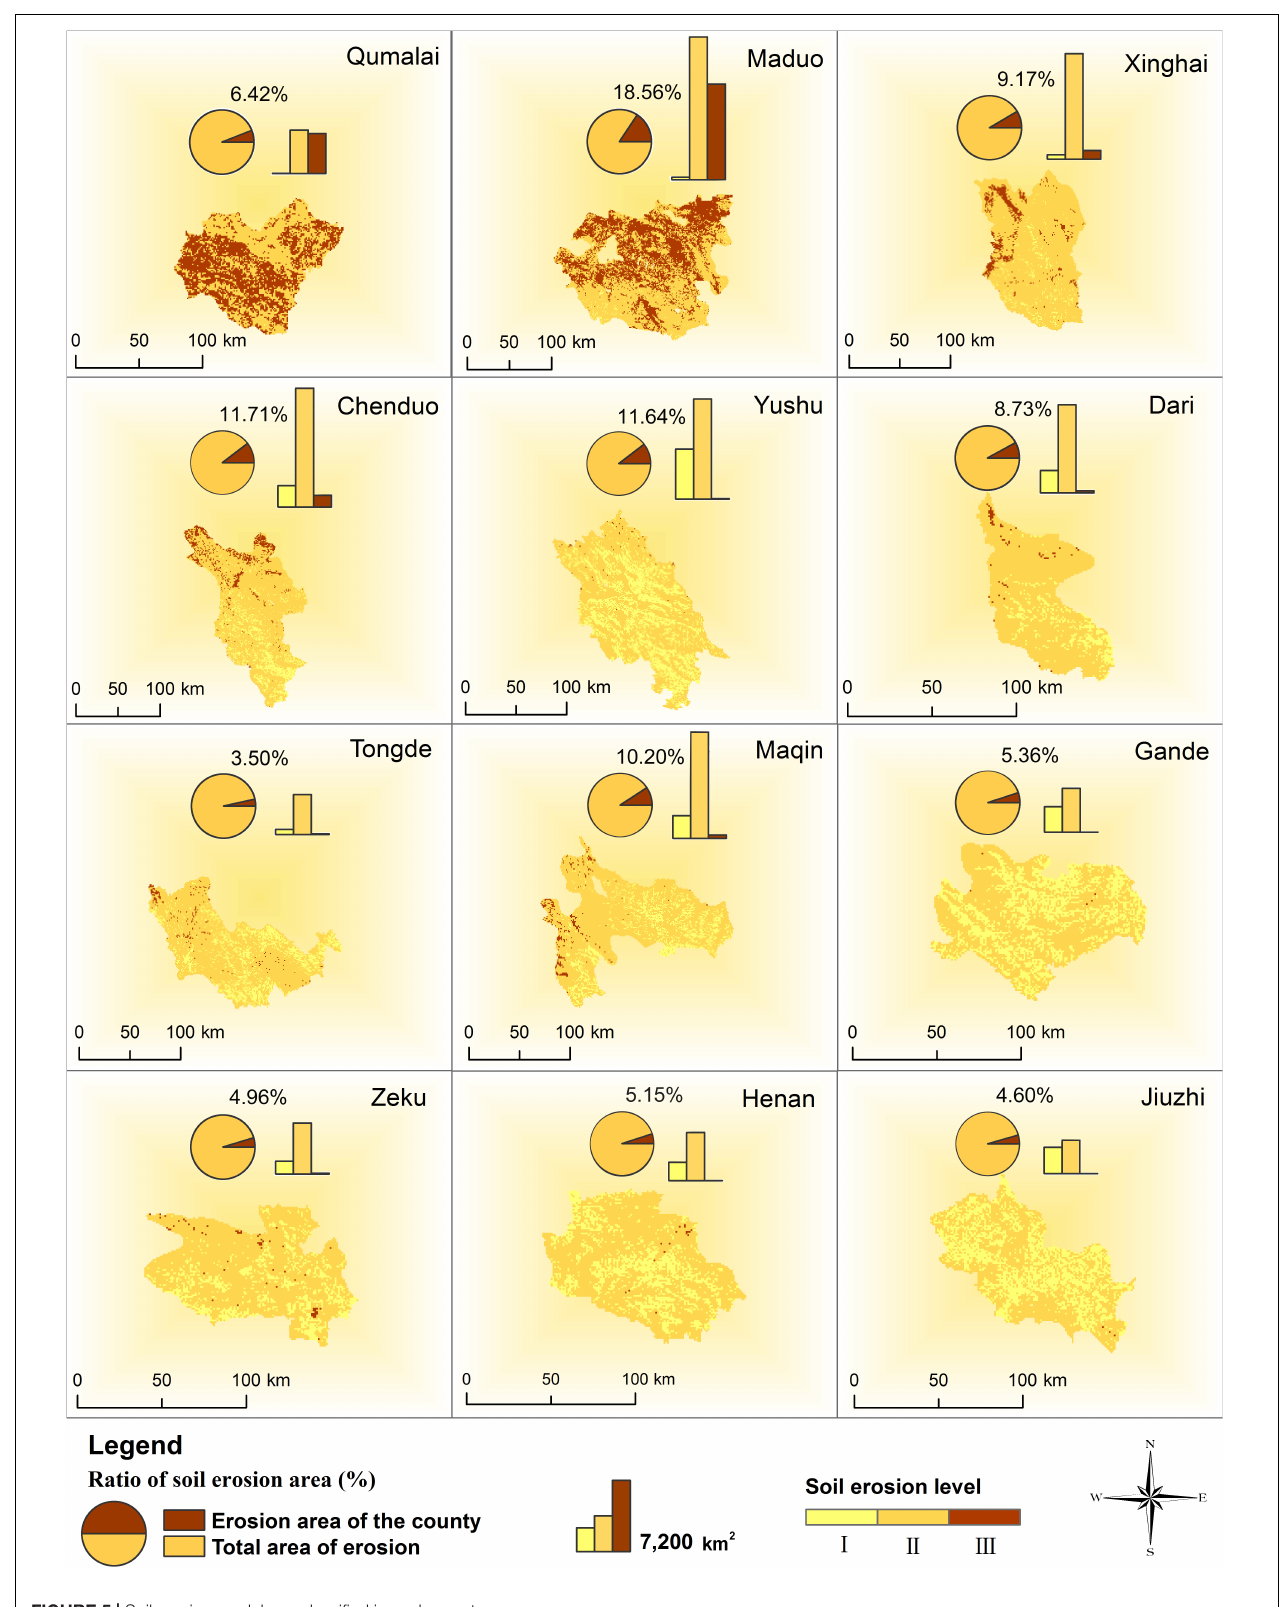
FIGURE 5 | Soil erosion modulus reclassified in each